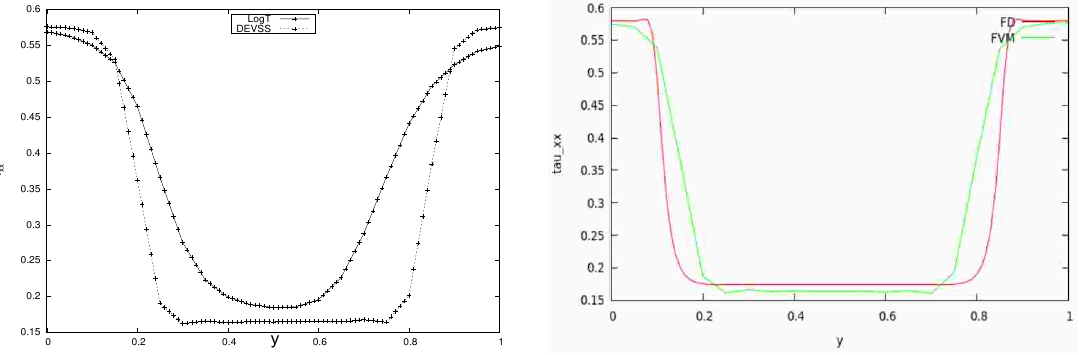
Figure 3. Normal stress profile ( τ xx = σ pxx ) for We = 2, η S = 0.05, η P = 0.95, ξ = 0.8, and Re = 1 for the Johnson-Segalman model (compared with reference [24]